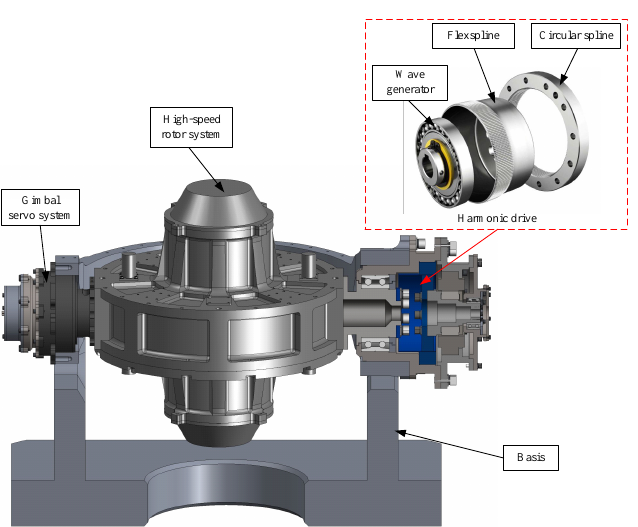
Figure 1. Structure diagram of